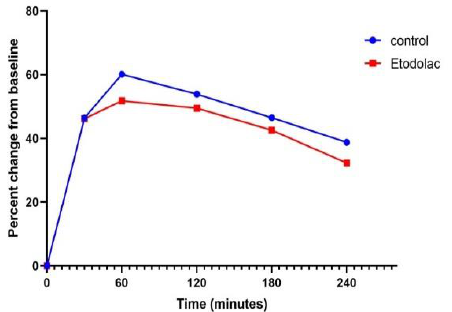
Figure (2) Effect of etodolac (reference), and dimethyl sulfoxide (control) on